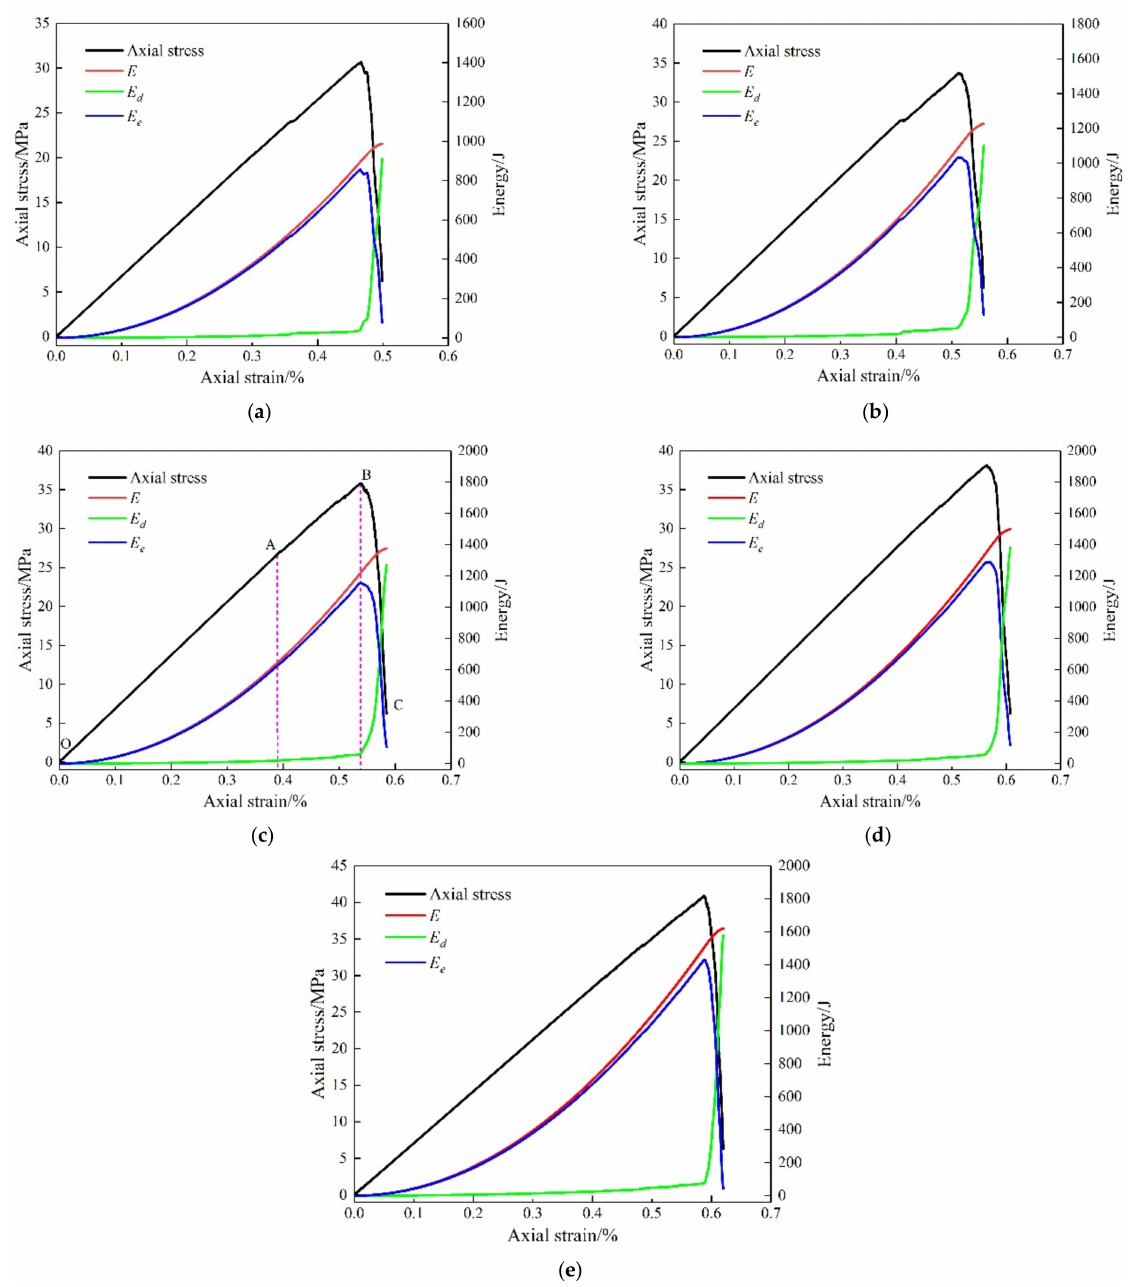
Figure 7. Energy evolution of a sample models with different flaw inclination angles. ( a ) β = 15 ◦ ; ( b ) β = 30 ◦ ; ( c ) β = 45 ◦ ; ( d ) β = 60 ◦ ; ( e ) β = 75 ◦